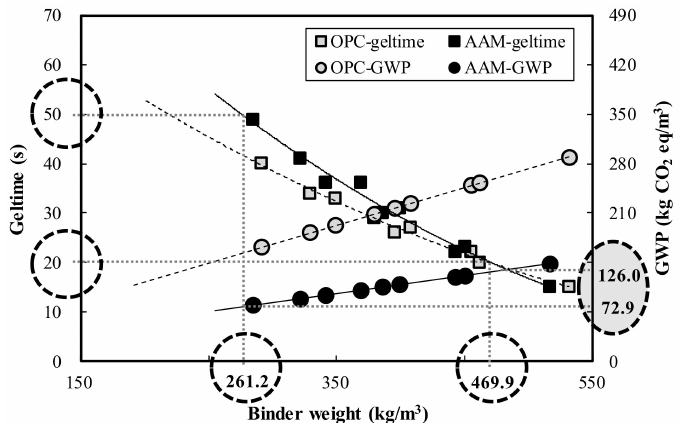
Figure 13. OPC and AAC binder weight range and GWP that satisfy the target